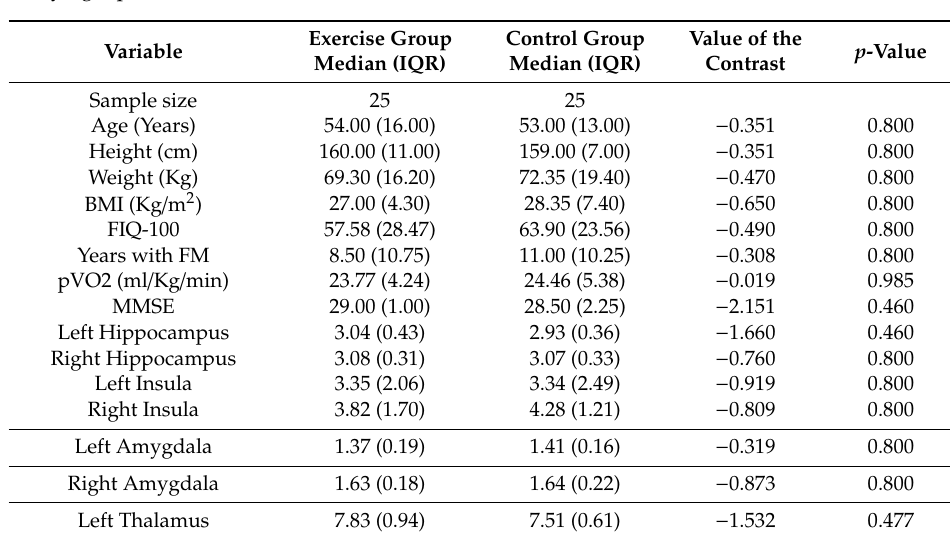
Figure 1. Flow chart of participants. Table 1. Descriptive characteristics of participants and di ff erences between groups at the baseline of fibromyalgia